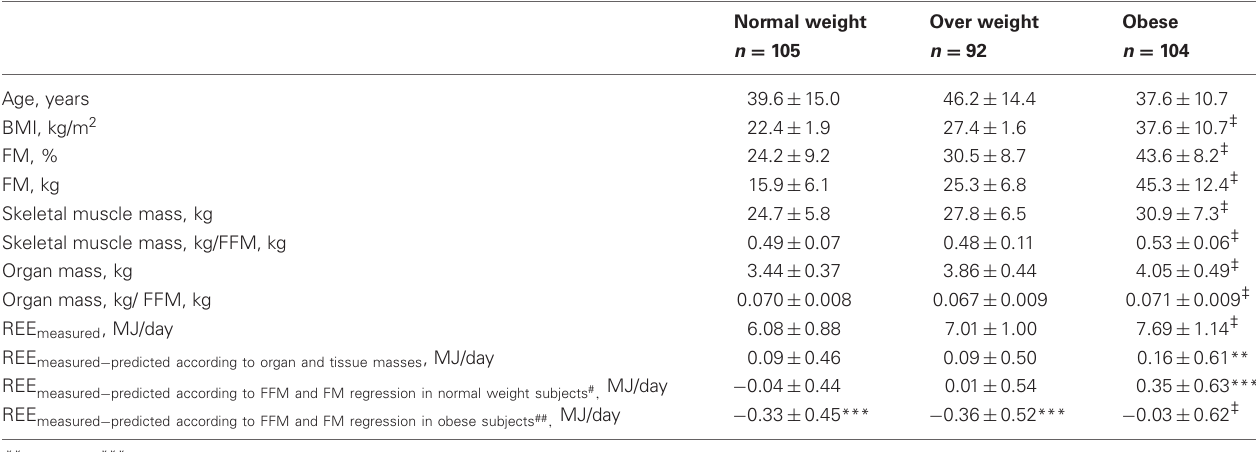
Table 3 | Comparison of basal characteristics and resting energy expenditure adjusted for body composition between normal weight, overweight, and obese participants of study population 1 .